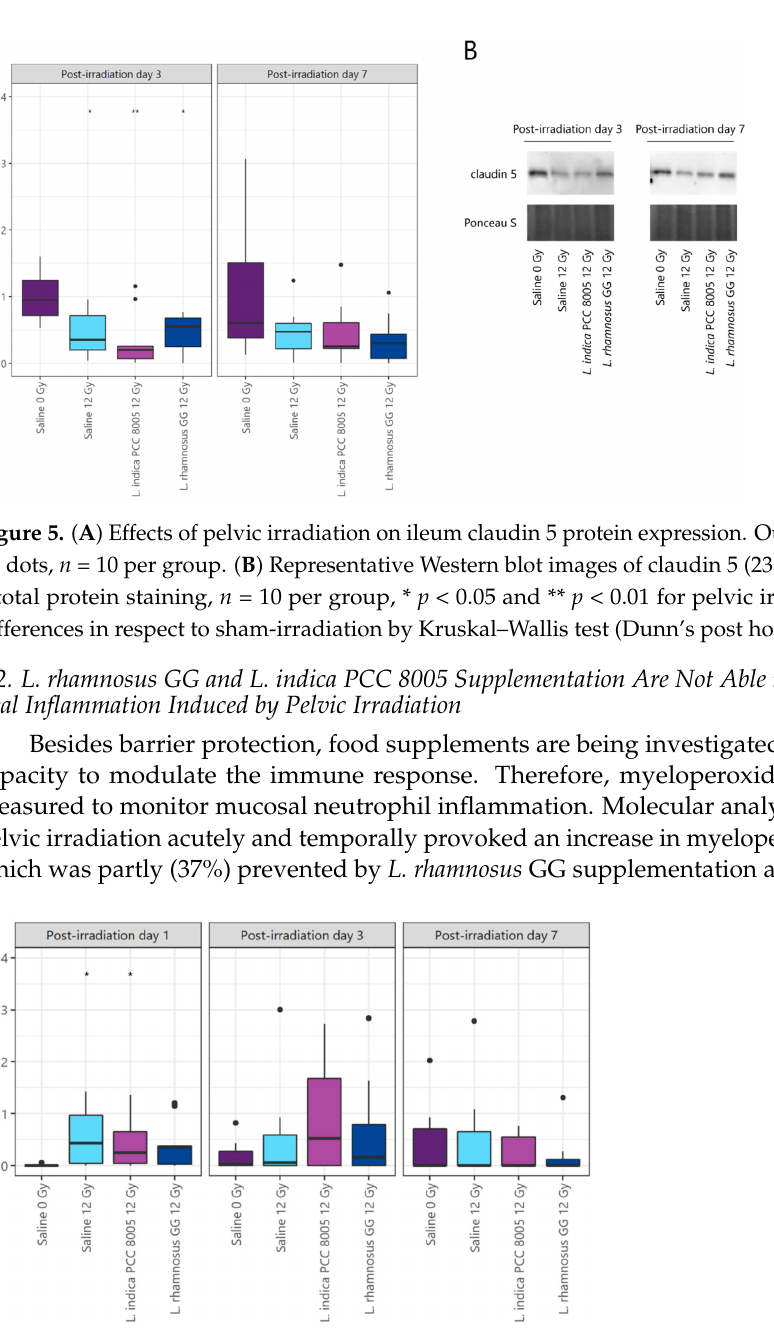
Figure 6. Ileal inflammatory myeloperoxidase activity following (sham-)irradiation. Outliers are depicted by dots, n = 10 per group, * p < 0.05 for pelvic irradiation-induced differences in respect to sham-irradiation by Kruskal–Wallis test (Dunn’s post hoc correction).